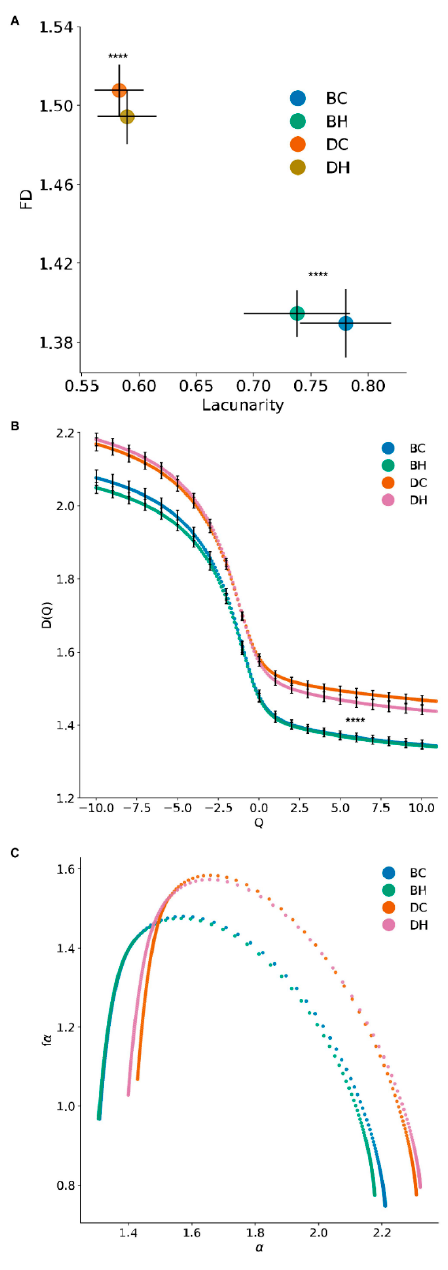
Figure 4. Fractal, lacunarity, and multifractal analysis of the mitochondrial network. ( A ) Mono-fractal and lacunarity analysis of the mitochondrial network. ( B ) Generalized dimensions of all mitochondrial regions for BC-BH and DC-DH. ( C ) Singularity spectrum f ( α ) versus α of BEAS-2B and DMS273 cells BC, BH, DC, and DH, respectively. **** p < 0.00001 values indicate significance from the Mann–Whitney test between control BC–BH cells and DC–DH tumor cells. Exact p -values for fractal dimension curves are reported in Table 1.